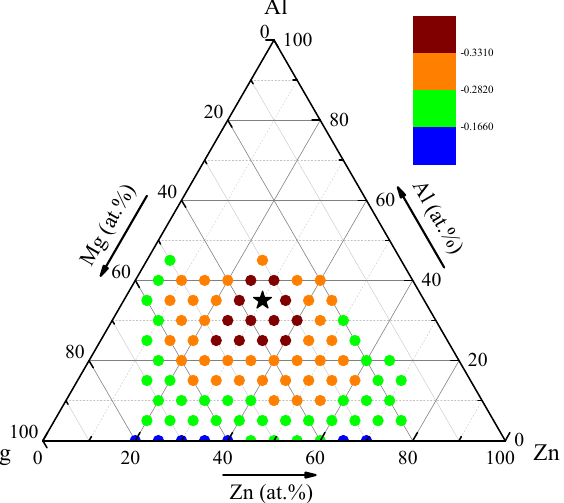
Figure 4. The distribution diagram of the amorphization driving force derived from the MC and MD simulations for the ternary Al-Mg-Zn system.